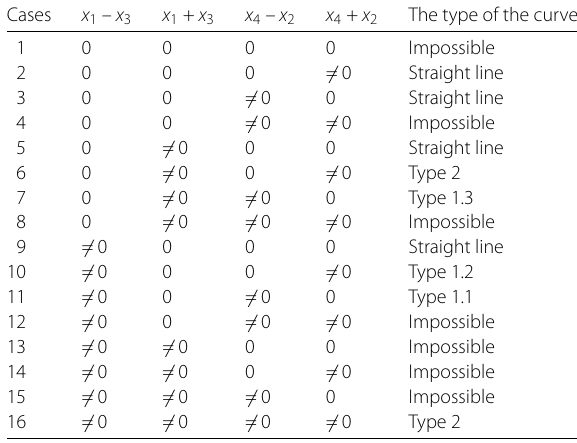
Table 1 All types of null curves in the lightlike cone Q 3